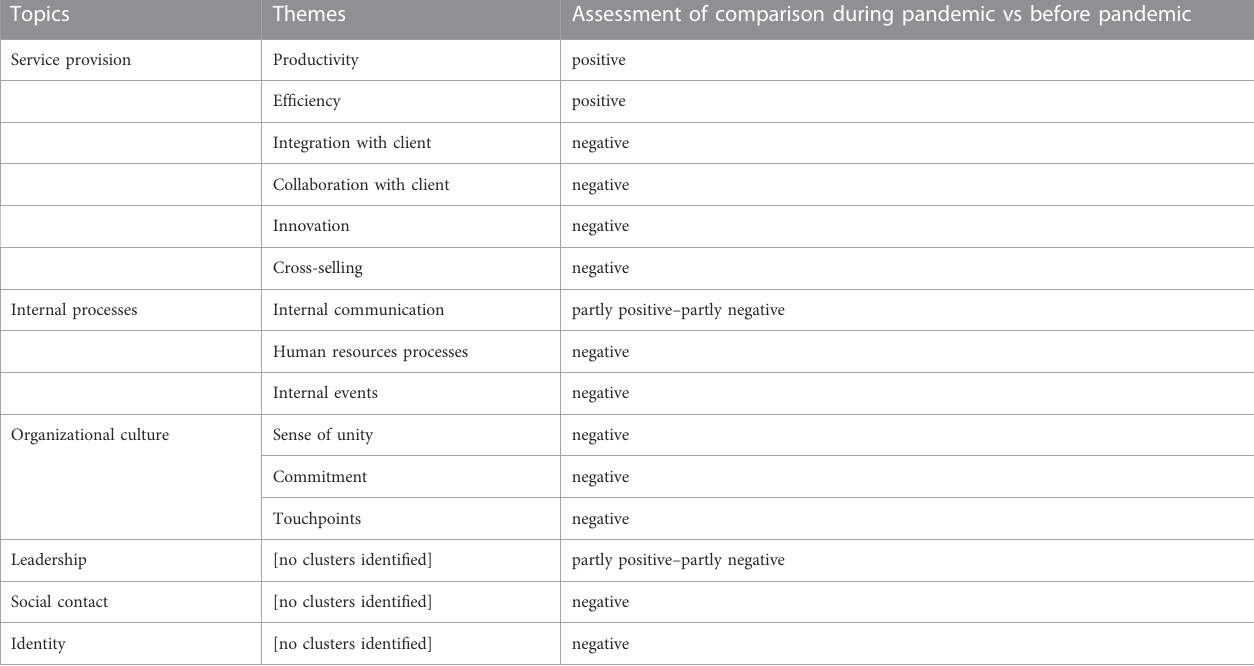
TABLE 1 Overview of topics, themes, and assessment of difference during the pandemic compared to before the pandemic.